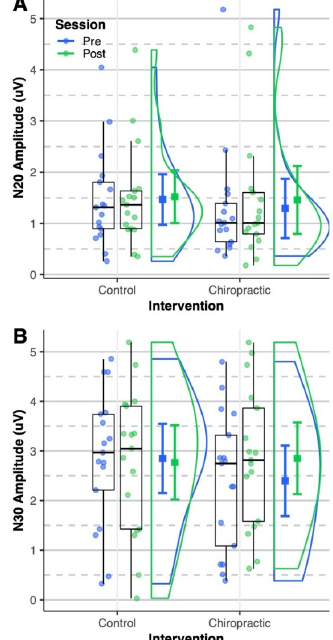
Figure 2. Somatosensory evoked potentials (SEPs) amplitude. Dots represent ( A ) N20 and ( B ) N30 amplitudes from all sessions of the analyzed subjects. Boxplots show the median, 25th and 75th percentiles. The error bars represent mean ± 95% CI. The distribution plots show the density distribution estimated by a Gaussian kernel with SD of 1.5. ( A ) The N20 amplitude was not a ff ected by either intervention. ( B ) The N30 amplitude was similar for the pre-intervention sessions. After the chiropractic spinal manipulation, the N30 amplitude increased significantly, however, it was not changed after the control intervention. The figure was made using the code provided by Allen et al.